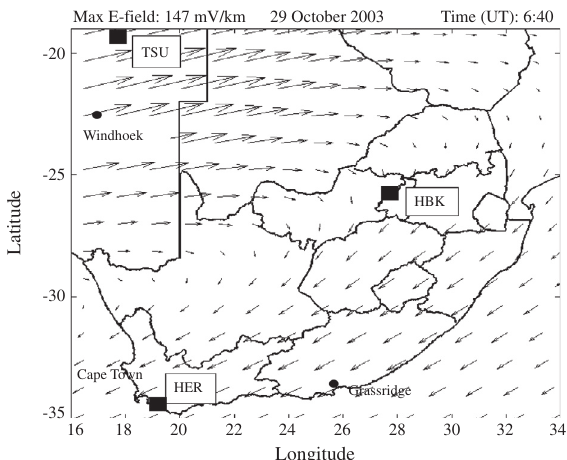
Fig. 2. Grid of interpolated horizontal electric field over Southern Africa on 29 October 2003 at 06:40, calculated using measured magnetic fields at